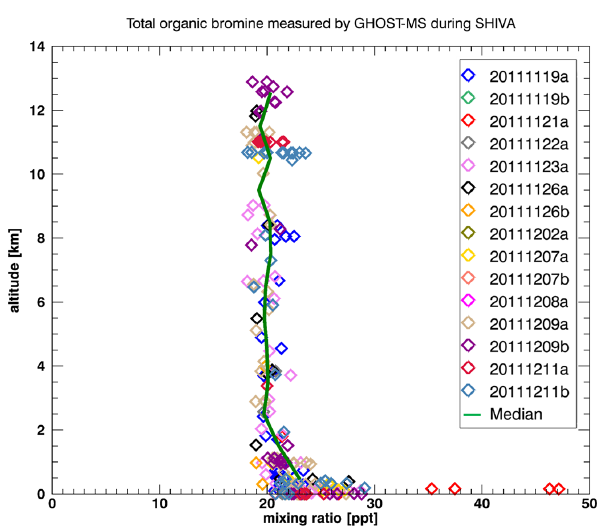
Figure 10. As Fig. 3, for total organic bromine. Only samples with mixing ratio data for all 10 bromocarbons are